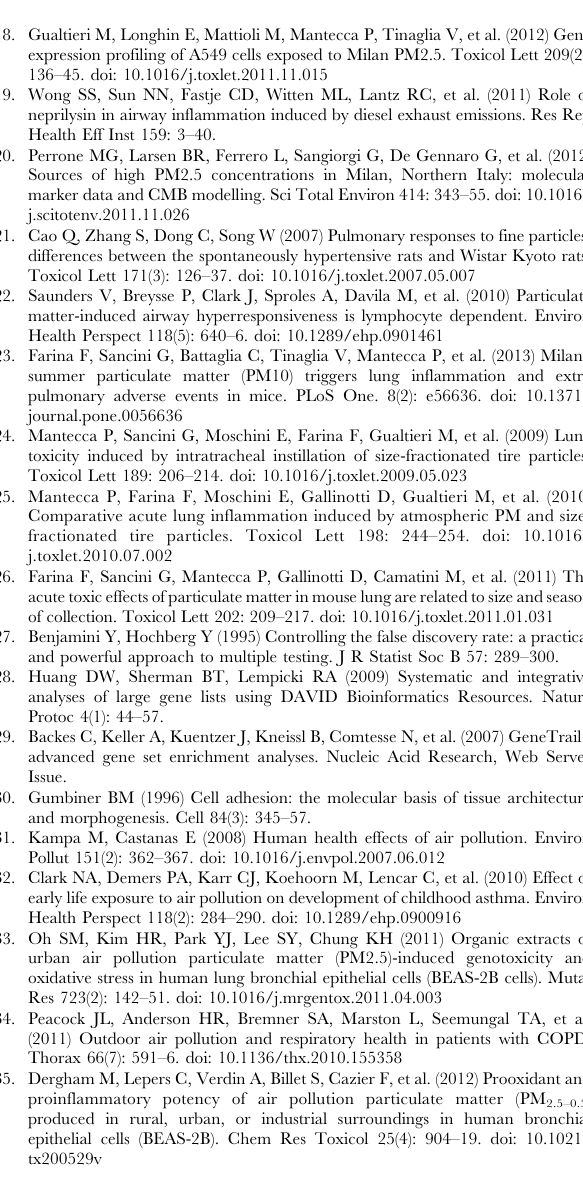
Figure S1 Lung differentially expressed gene (DEG) distribution. Distribution of 57 DEG according the p value (horizontal axes) and Fold Change value (vertical axes). Figure S2 Heart differentially expressed gene (DEG) distribution. Distribution of 359 DEG according the p value (horizontal axes) and Fold Change value (vertical axes). Table S1 Global gene expression in lung tissue. List of differentially expressed gene (DEG) of lung exposed to PM.2.5win; in lung tissue of PM2.5win-treated mice 14 up- and 43 down- regulated genes have been found. Table S2 Global gene expression in heart tissue. List of differentially expressed gene (DEG) of heart exposed